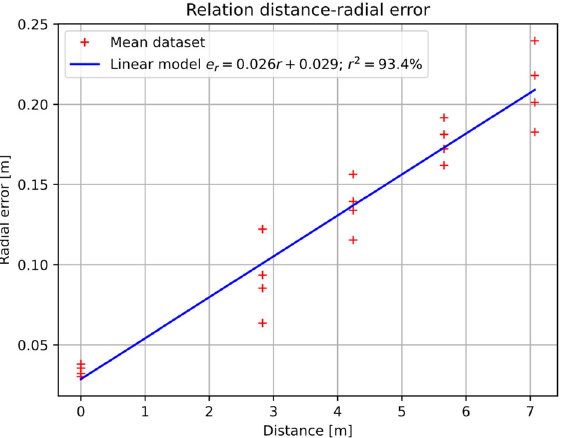
Figure 12. Relationship between distance and radial error. Red + symbol, centroid of each position. Blue line, linear model fitted by least squares.